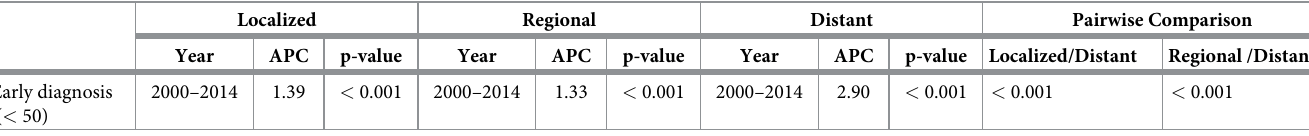
Summary of localized, regional, and distant joinpoint models for the early onset patients ( < 50 years of age at diagnosis). Each segment is given as a year range with the estimate of the annual percent change (APC) and the p-value associated with the APC. Pairwise comparison p-values (testing for parallel trends) of regional and distant are